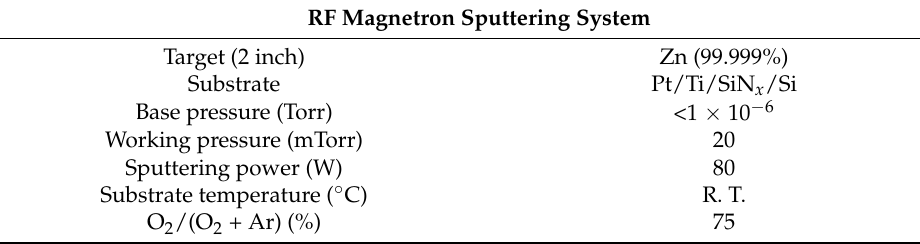
Table 2. Deposition parameters of the ZnO thin films.